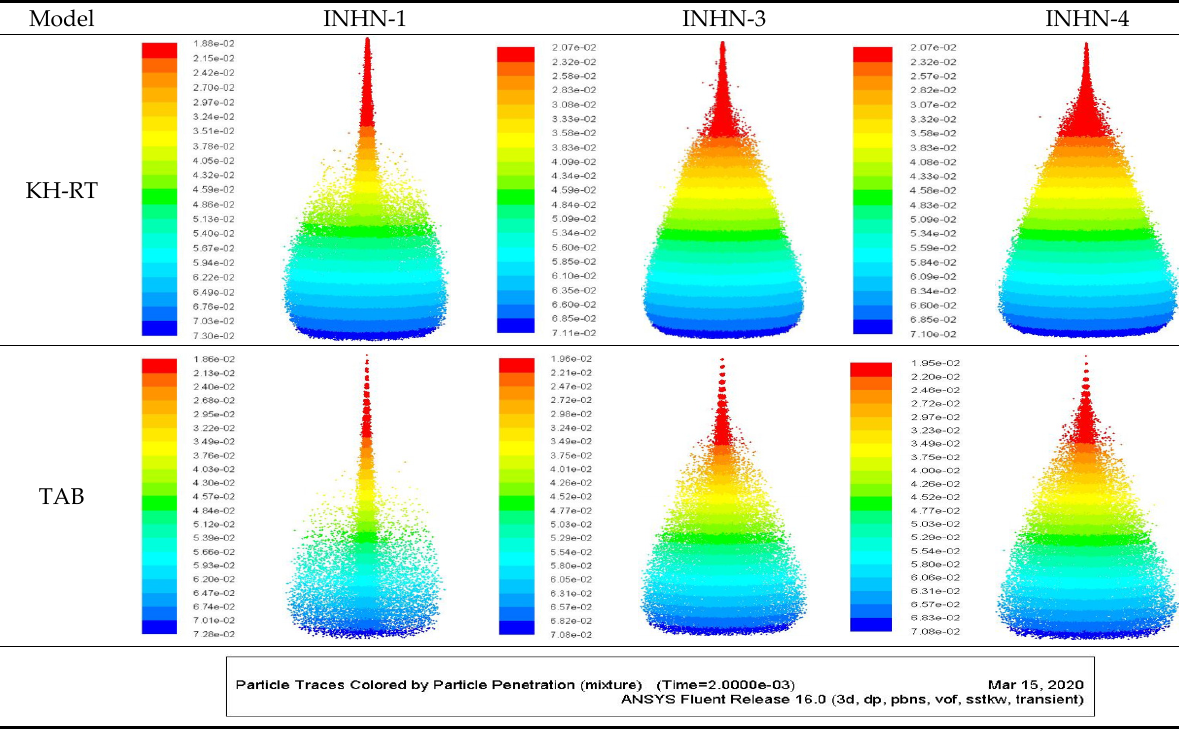
Figure 11. Particle penetration for different injector nozzles. (c) Influence of INHNs and orifice size on the spray particles velocity Because of the higher pressure differential, velocity increases slightly when it enters the chamber at a 200 bar injection pressure. However, this rise was not seen in INHN-1, and INHN-3 velocities are higher than INHN-4 velocities at the same axial positions. The velocity declines rapidly at first, then increases, and then gradually decreases till the end, as illustrated in Figure 12.